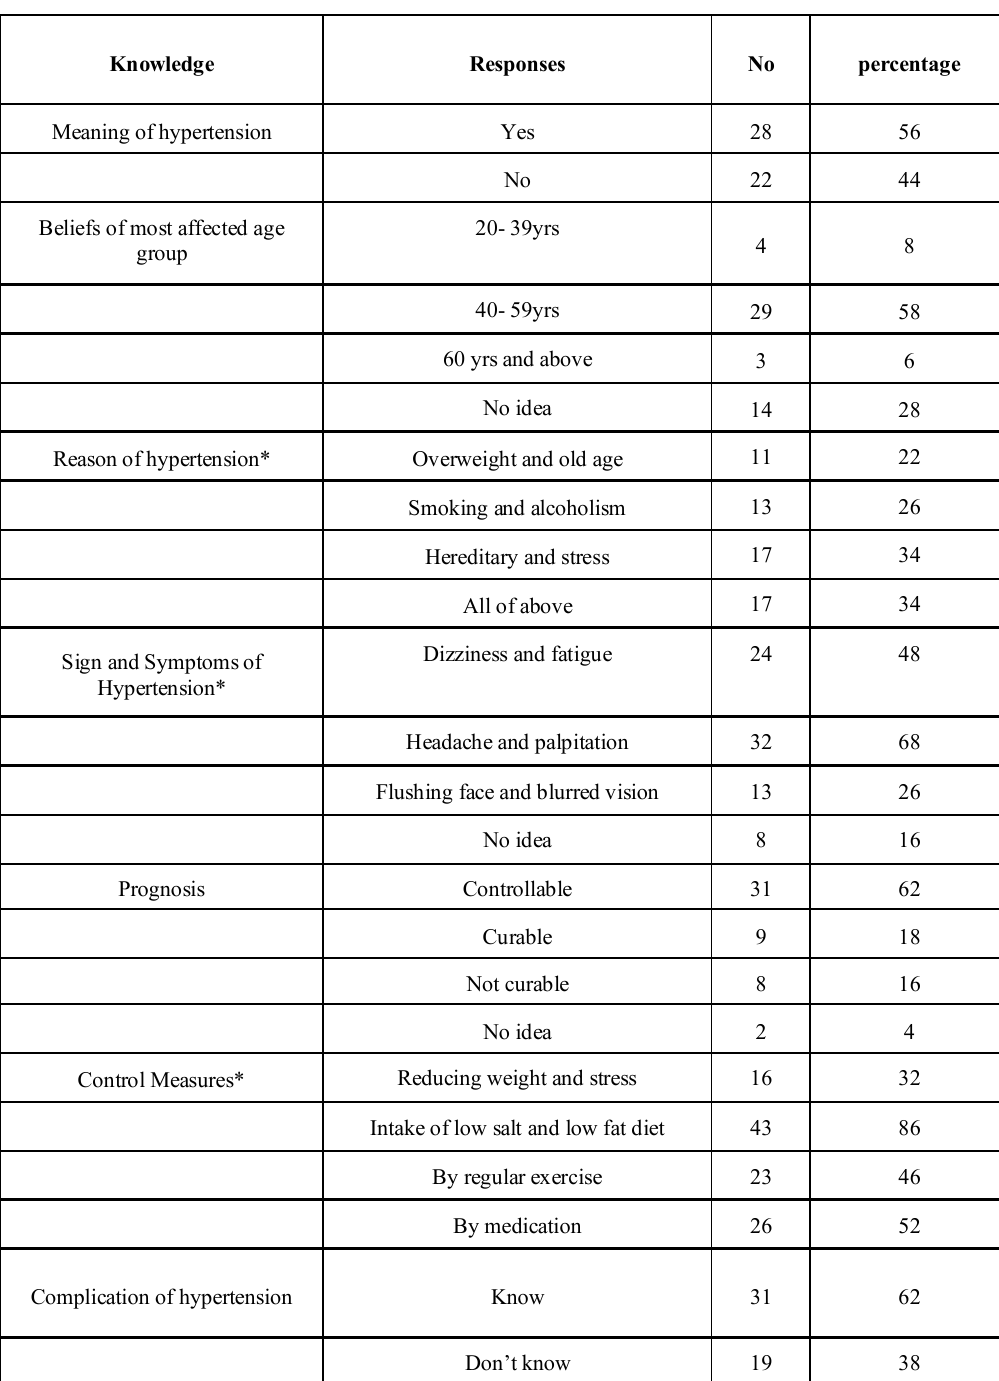
Table 2: Distribution of respondents according to their knowledge about hypertension (N=50)